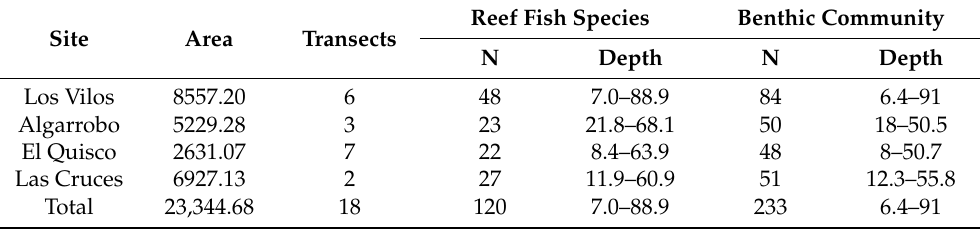
Table 1. Sampled sites (see Figure 1 for location details), sampled area (m 2 ), and number of transects performed. For each dataset, the total observations (N) and sampled depth range (m) are specified. Observations correspond to video sections for reef fish species and 0.25 m 2 quadrats for the benthic community. Depth for reef fish species corresponds to the mean depth of the video